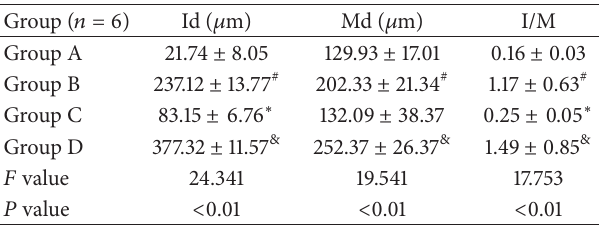
Table 2: Thicknesses of tunica intima and tunica media and their ratios (mean ±